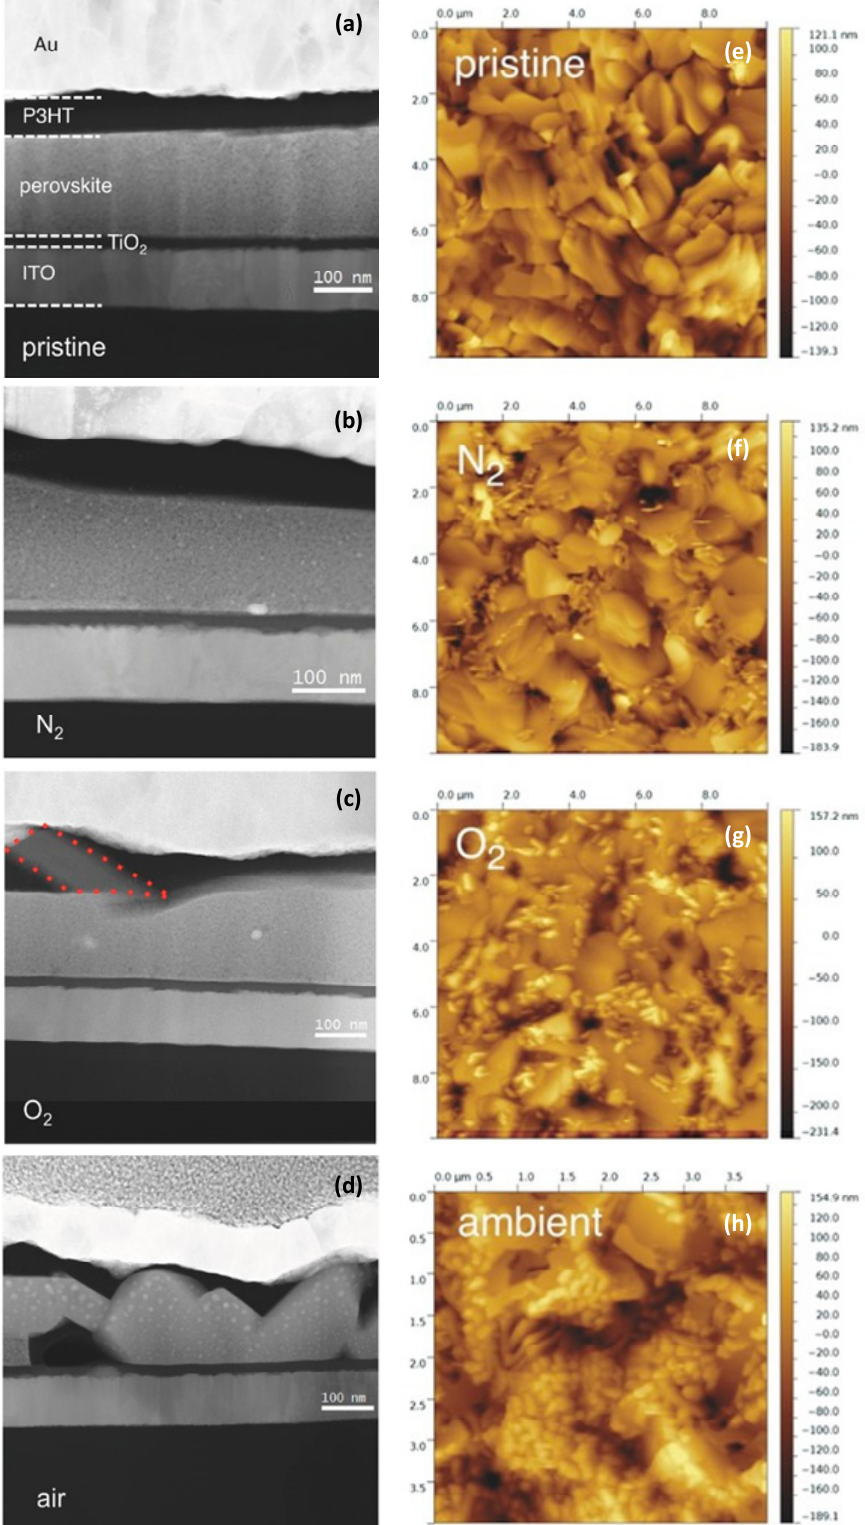
Figure 4. ( a – d ) Cross-sectional views of perovskite solar cells heated at 85 ◦ C for 24 h in different atmospheric conditions. The area highlighted in red in the degraded device in O 2 environment indicates the presence of PbI 2 grain. ( e – h ) Topographical AFM images of perovskite films that were heated at 85 ◦ C for 24 h in different atmospheric conditions. Reprinted from [38] with permission.